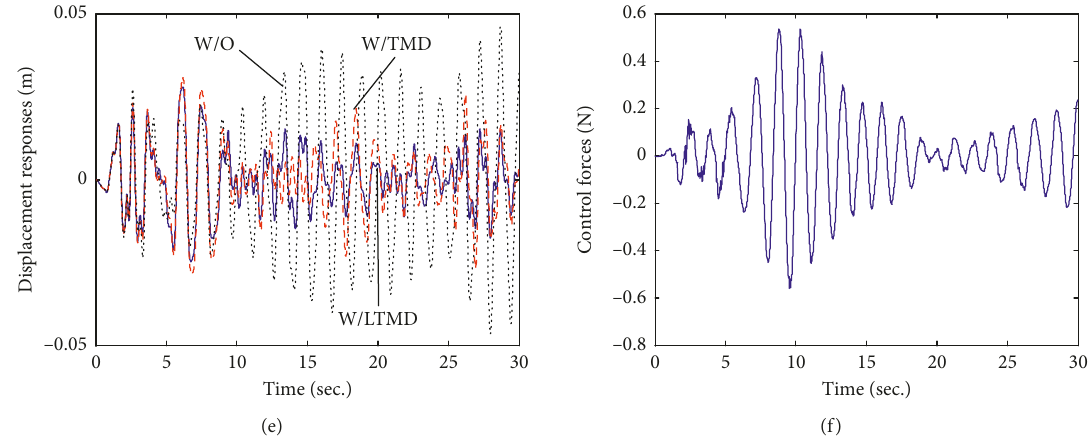
Figure 6: Numerical results of dynamic responses using the mass ratio μ and η 1 . 0; (b) SRSS according to α and η at fixed values of β (cid:29) c 0 . 7, and η 0 . 95; (d) dynamic responses (2 nd floor); (e) dynamic responses (1st floor); (f) control forces at the upper mass of the (cid:29) (cid:29)